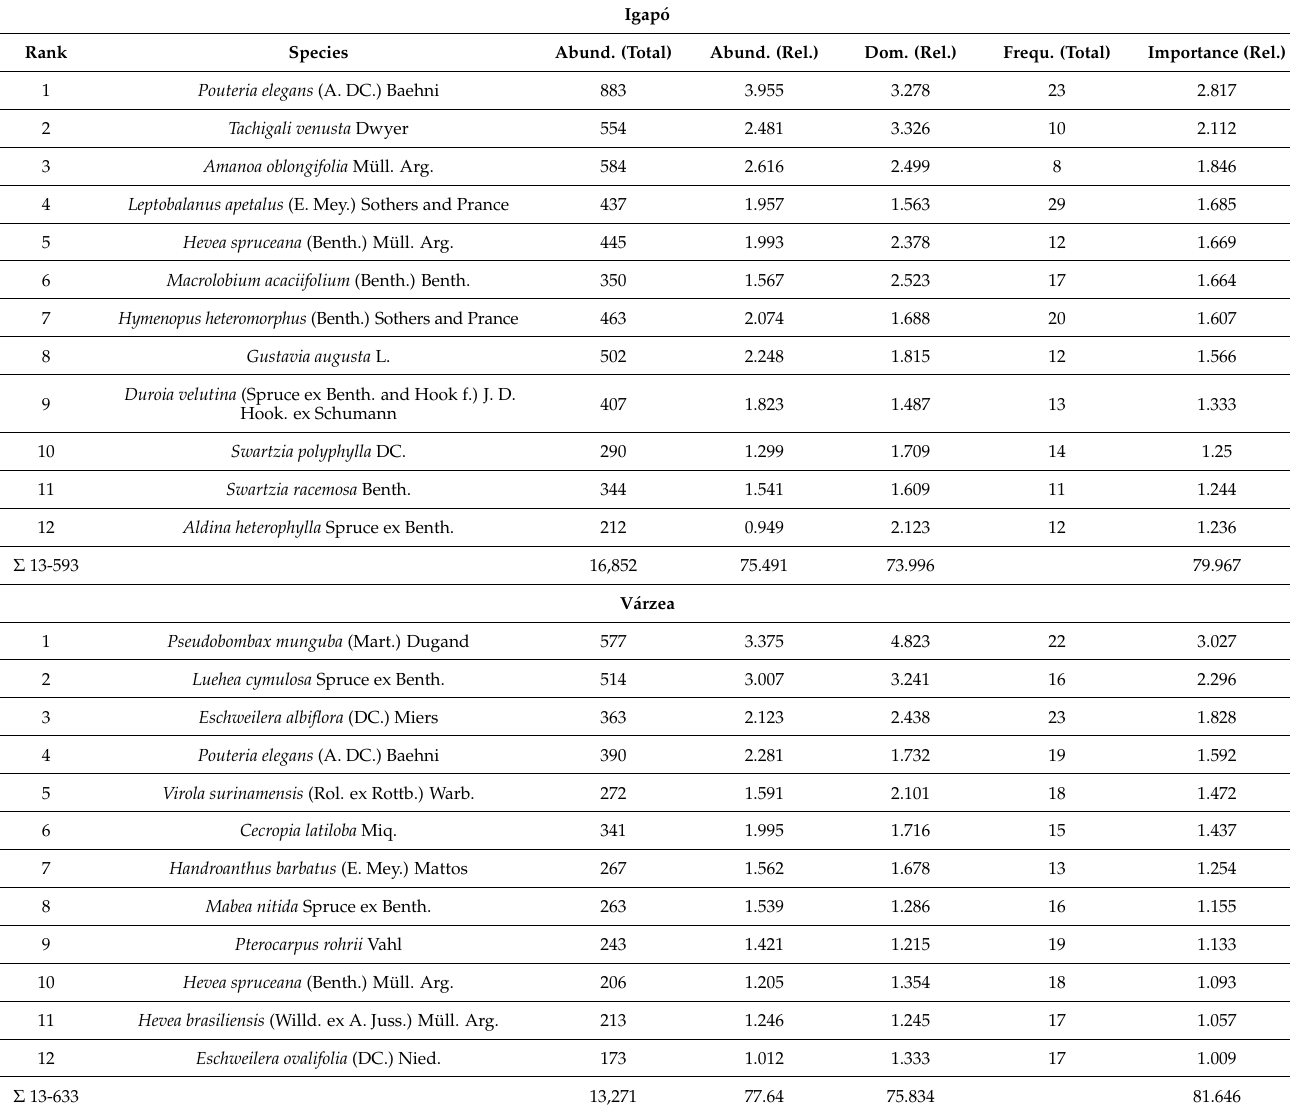
Table 3. Relative overall importance of the 12 most important tree species in central Amazonian igap ó and v á rzea forests, based on the floristic inventories presented in Table 1. Igap ó Species Abund. (Total) Abund. (Rel.) Dom. (Rel.) Frequ. (Total)